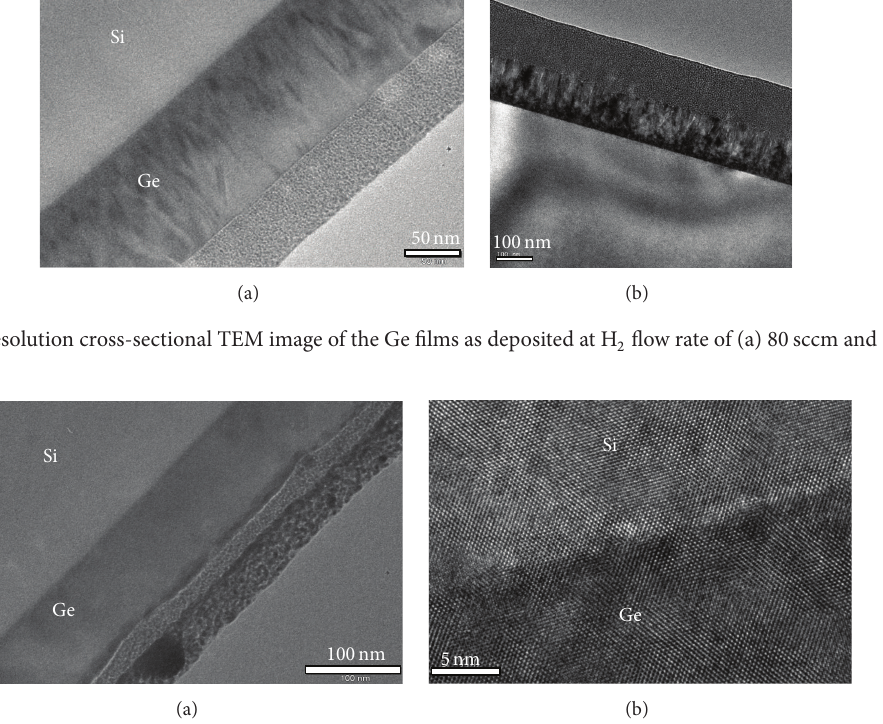
Figure 4: (a) High resolution cross-sectional TEM image of the Ge films annealing at 700 ∘ C; (b) Ge/Si